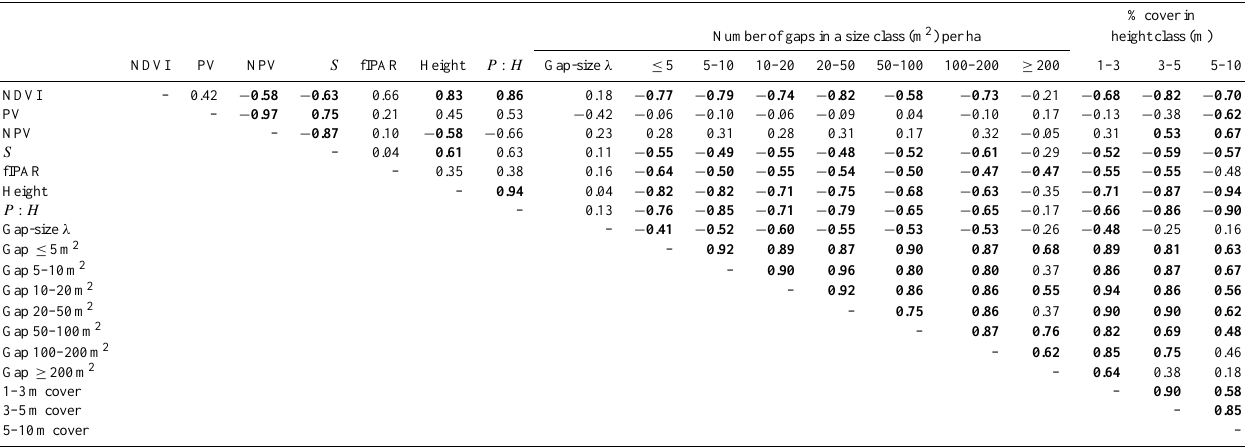
Table 3. Inter-relationships among landscape-scale canopy functional and structural traits along the elevation gradient. Values are Pearson Product Moment correlation coefficients ( r ) with bold font indicating p values ≤